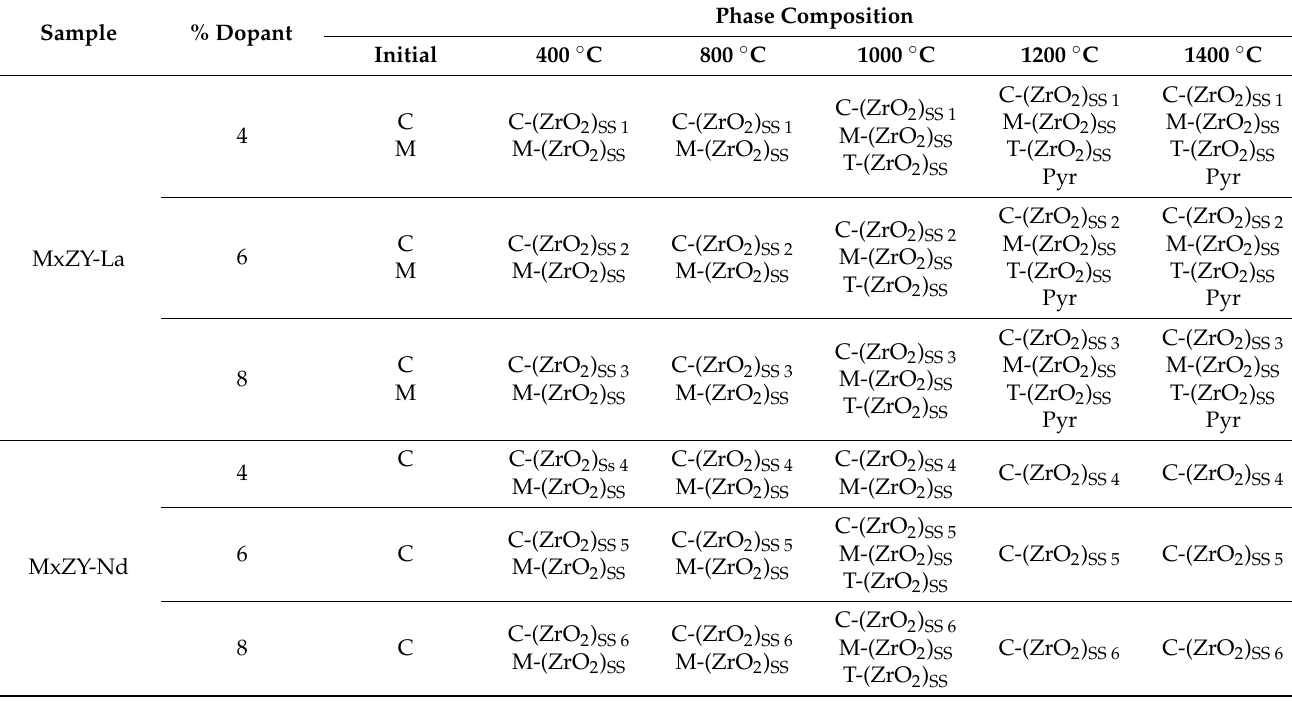
Table 1. Qualitative phase analysis of ZrO 2 co-doped with 8 wt.% Y 2 O 3 and 4/6/8 wt.% Ln 2 O 3 powders initials and after